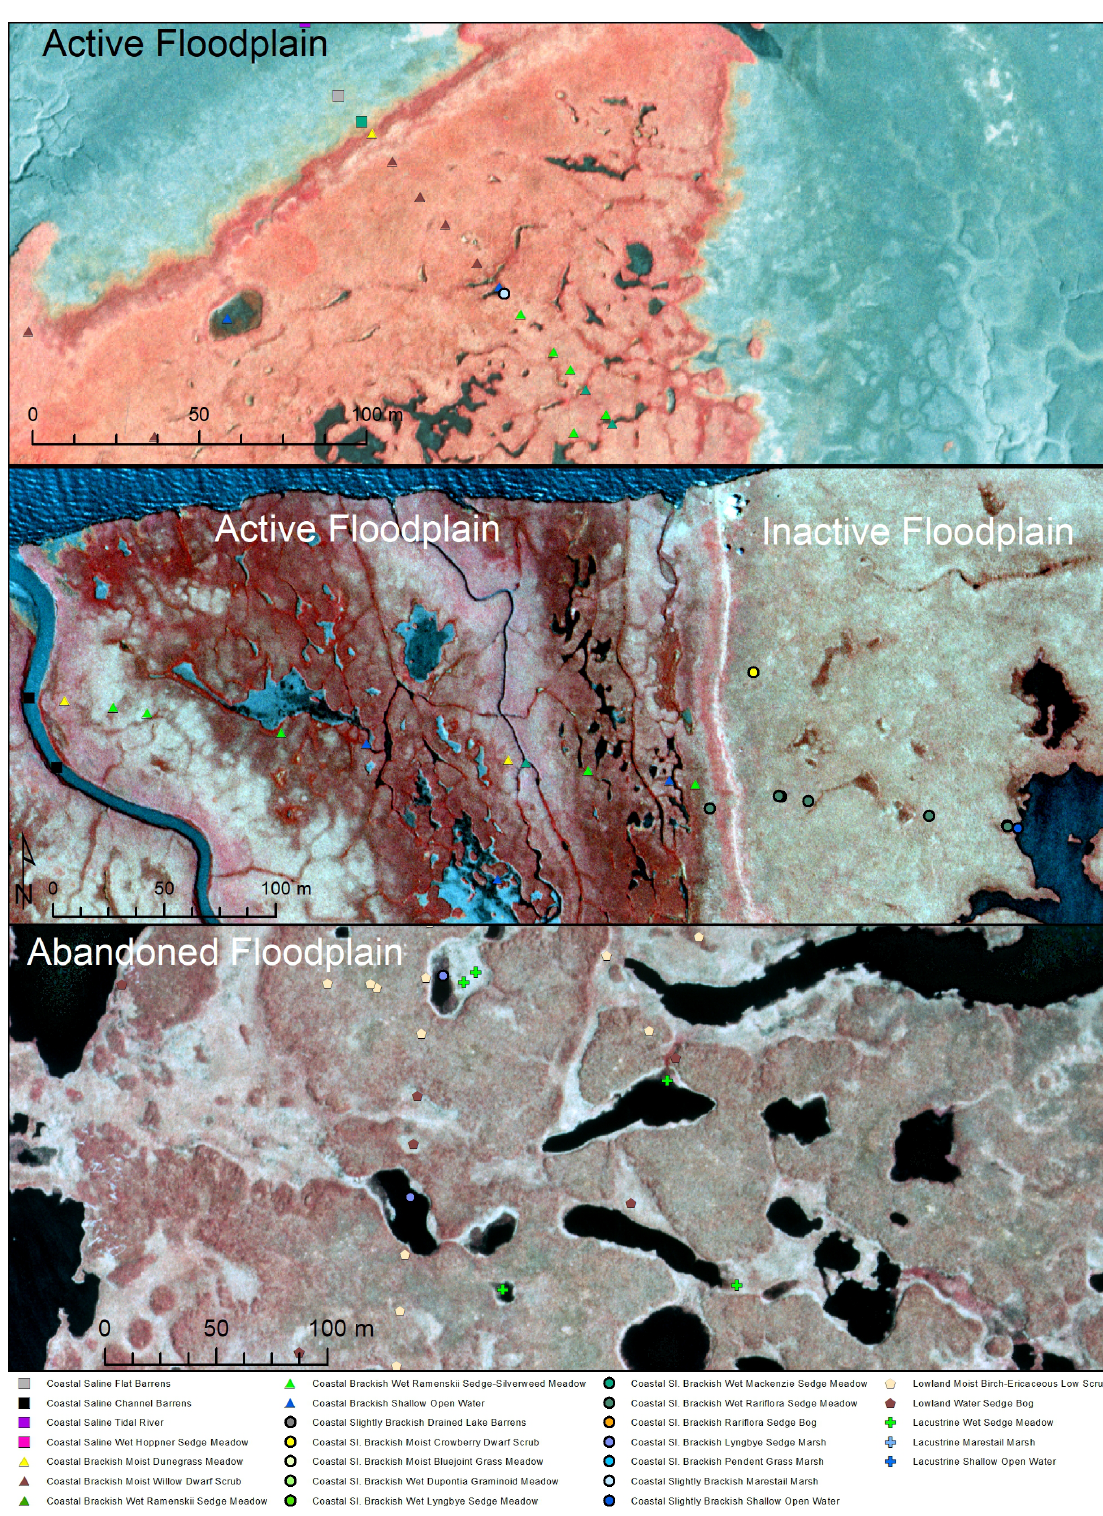
Figure A2. Examples of ecotypes evident on aerial photography as determined at ground reference plots situated on active, inactive and abandoned floodplain